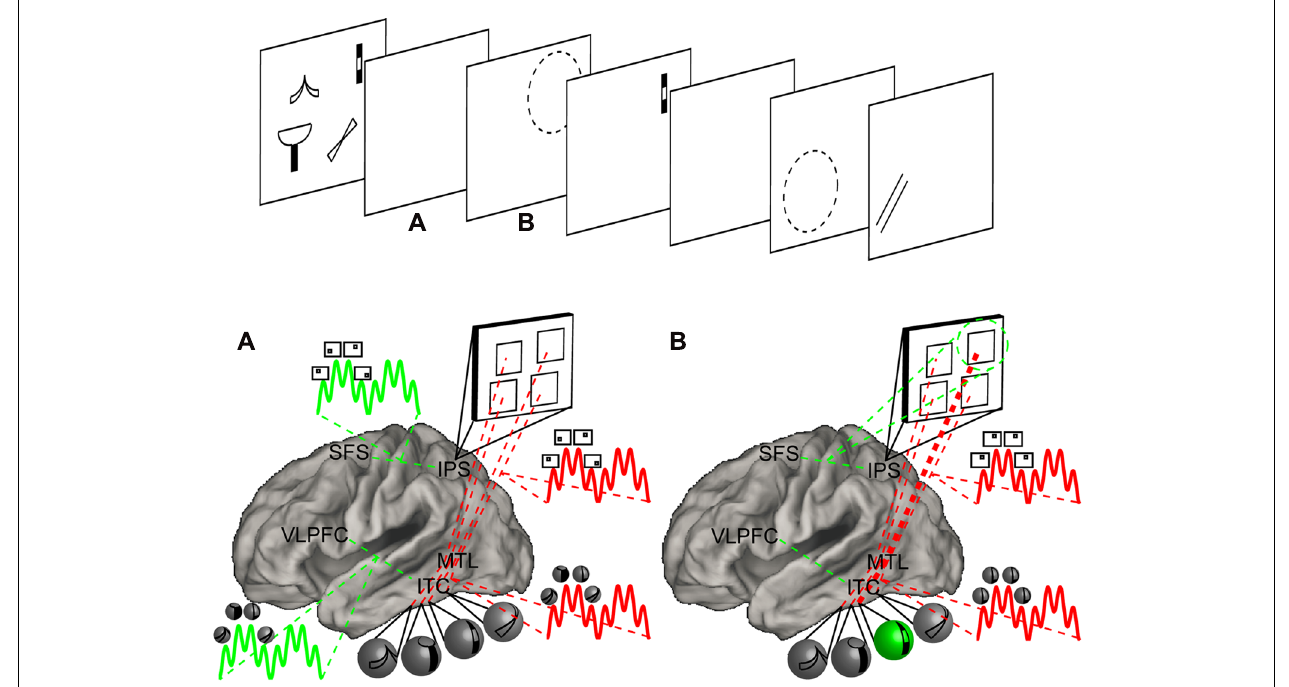
MTL synchronizes the activity of the IPS and ITC in the theta range. Within each theta cycle, stimulus-specific neurons fire in the gamma range. Thus, gamma activity nested within theta activity reflects the cycling of items within a set. Moreover, item-location bindings are implemented by MTL-mediated synchronized activity in the ITC and IPS. The connections and synchrony correspond to the direct-access region. At the same time, the VLPFC acts upon the ITC to support item-based maintenance. Here also, individual items are nested within oscillatory activity. These mechanisms periodically maintain the activity corresponding to each item in STM and correspond to the focus of attention cycling among the direct-access region. The SFS performs a similar function in concert with the IPS to cycle among locations. (B) When a cue directs attention to a spatial location, cycling ceases. Instead, the SFS fixates on the cued location thereby forming the focus of attention. Sustained spatial attention then activates the corresponding object through connections established by previous synchrony. While attention is sustained, only the attended location and corresponding object are instantiated by active neural firing. The synchronous activity between neurons corresponding to location representation and object representation strengthen the bindings between them (thickened red line) potentiating future cued